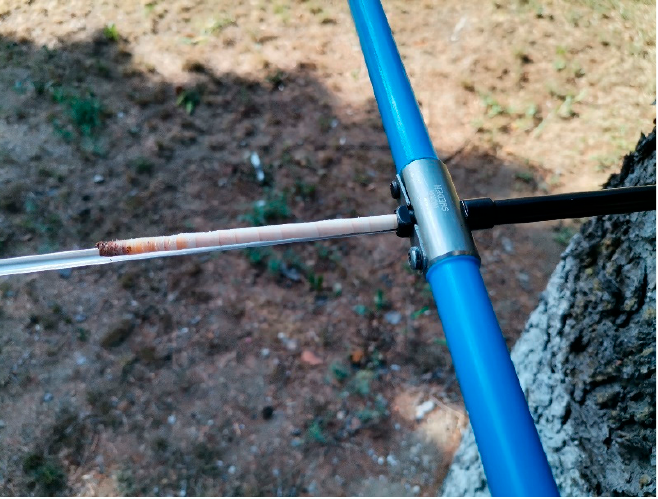
Figure 2. The samples for density measures.